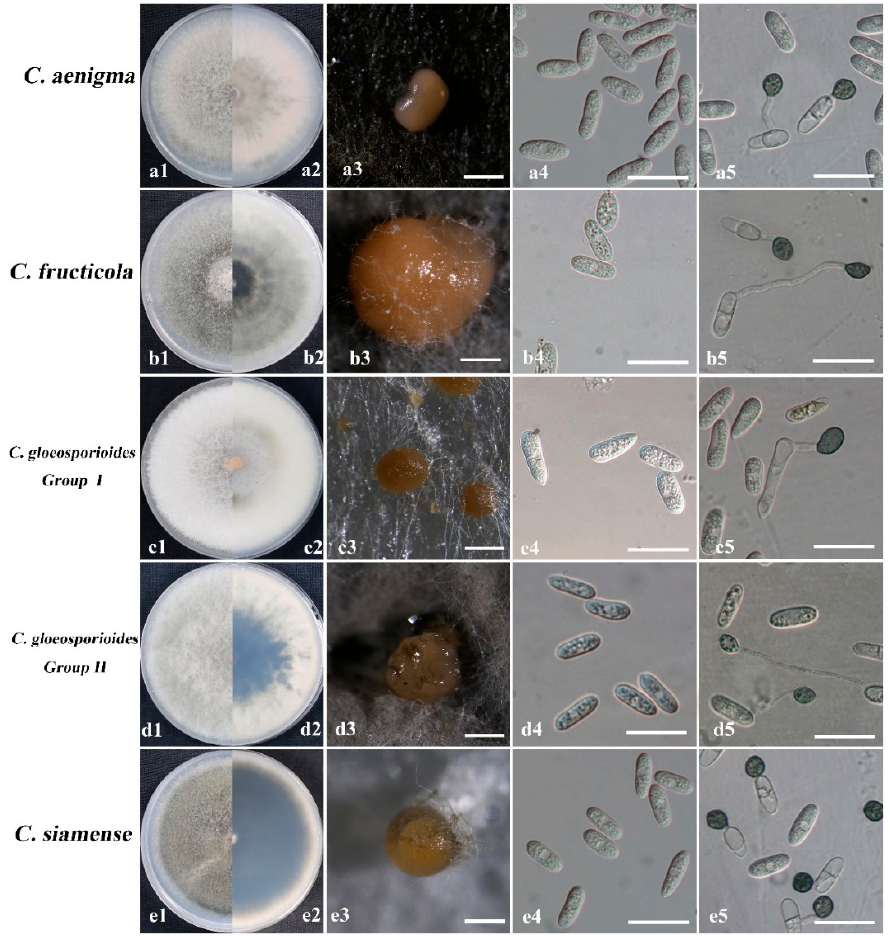
Figure 4. Culture characteristics and microscopic features of the four species within C. gloeosporioides complex: ( a1 – e1 ) upper side of 7-day-old colonies on PDA medium; ( a2 – e2 ) reverse side of colonies on PDA medium; ( a3 – e3 ) conidiomata; ( a4 – e4 ) conidia; and ( a5 – e5 ) appressoria. Scale bars: a3 – e3 = 500; a4 – e4 = 20; a5 – e5 = 20 μ m. Table 2. Morphological data of Colletotrichum isolates on PDA medium.